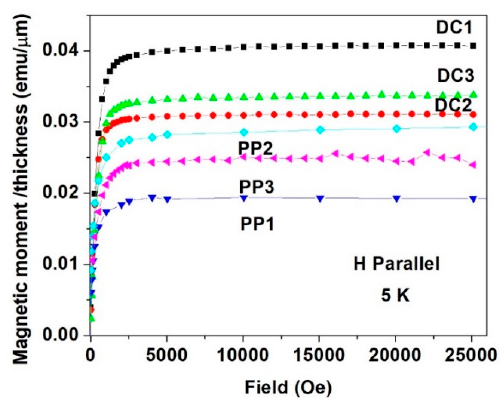
Figure 12. Parallel field dependence of the magnetic moment curves measured at 5 K for all DC and PP deposited quaternary Sn-Fe-Ni-Co alloy coatings.